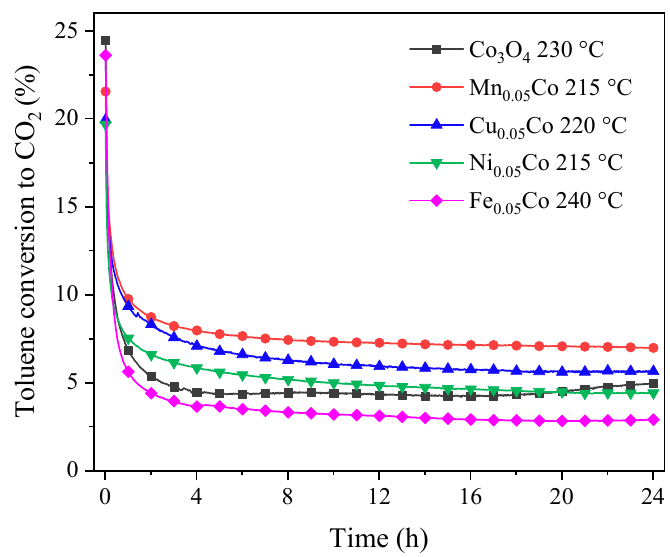
Figure 7. Toluene oxidation test conducted at 20 − 25% of toluene conversion during 24 h.